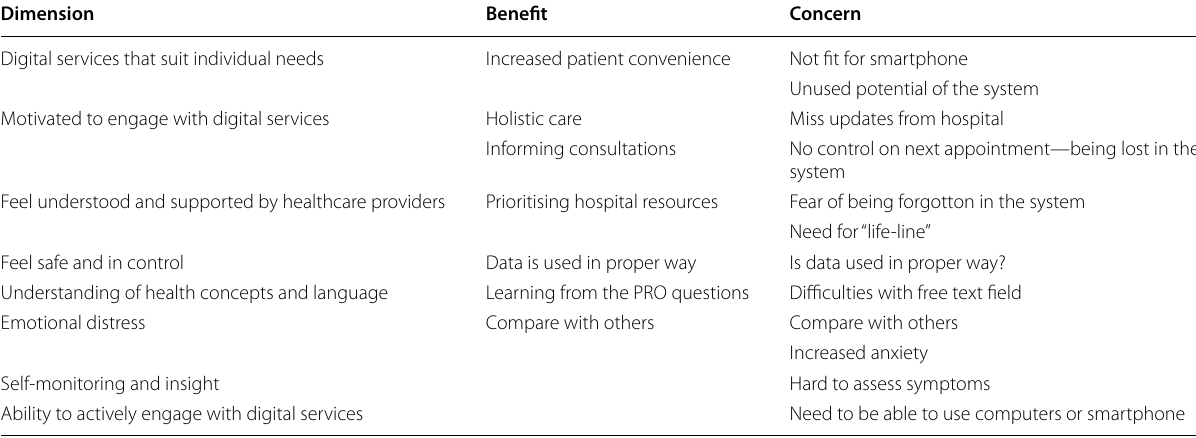
Table 2 Themes in interviews with IBD patients—grouped into ReadHy dimensions